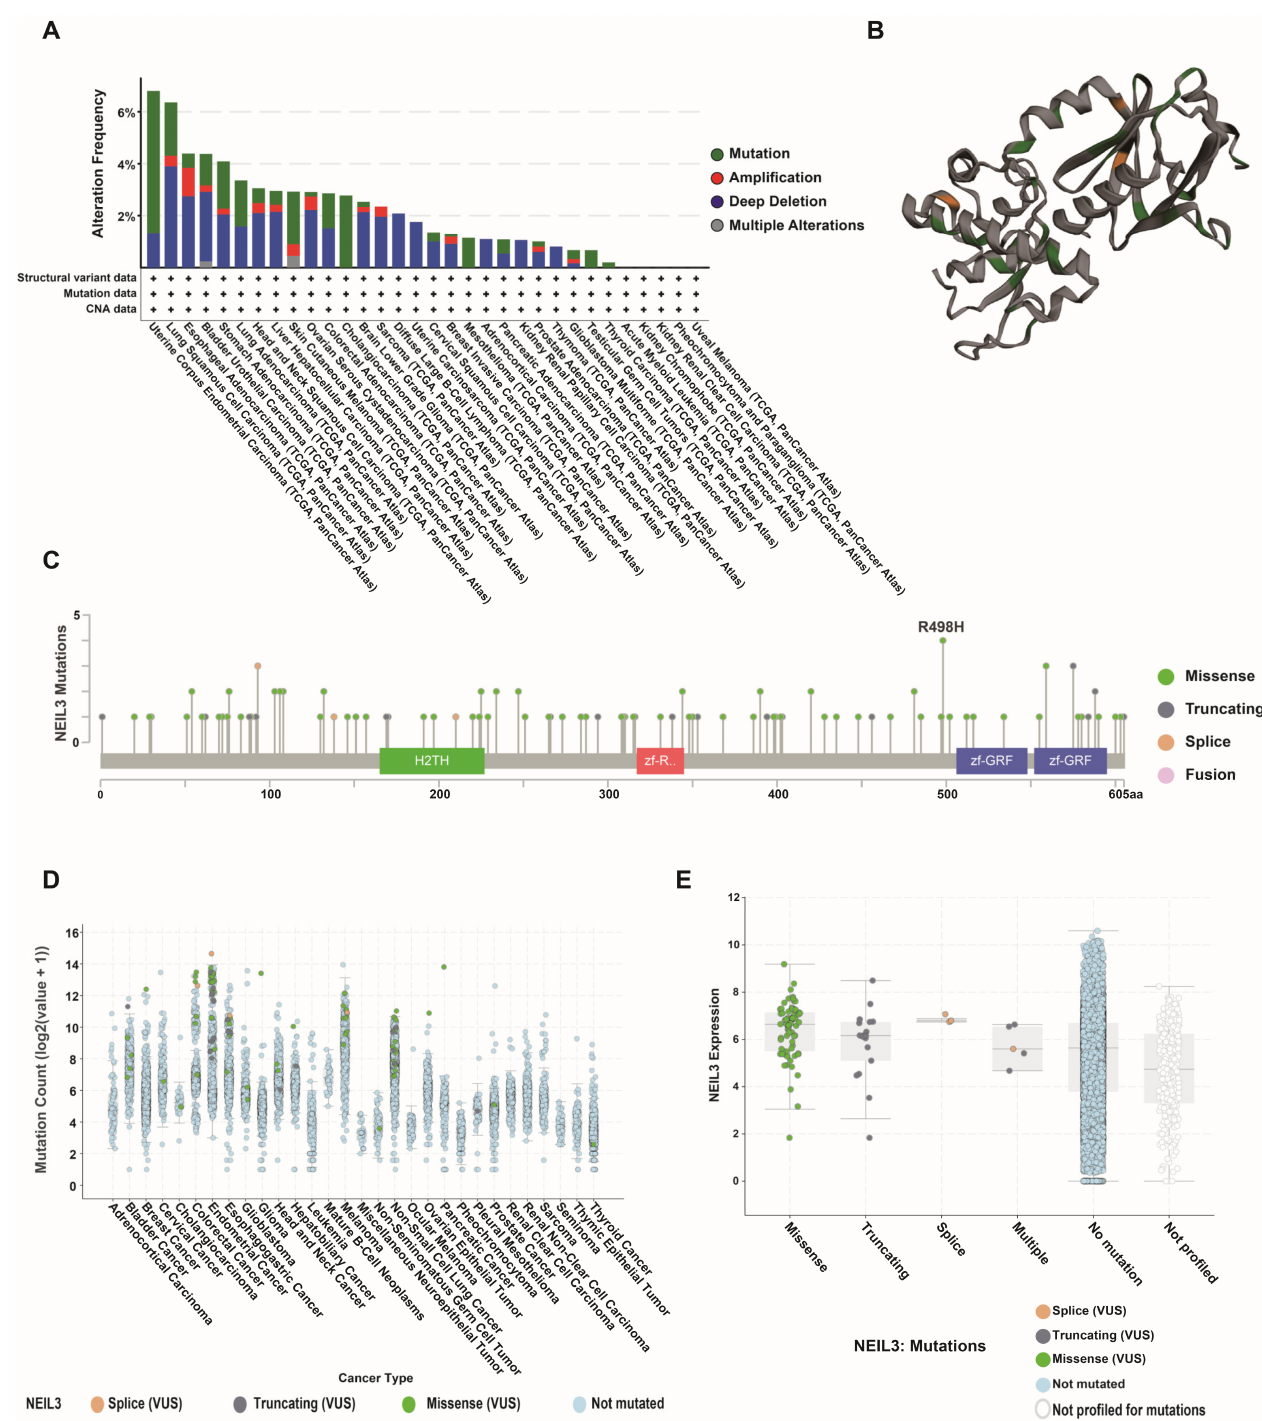
Figure 3. Mutation features of NEIL3 among cancers. ( A ) Alteration frequency of NEIL3 among 33 types of cancers. ( B ) Three-dimensional structure diagram of the NEIL3 protein. The green part represents the missense mutation area, black represents the truncating mutation area, and orange represents the inframe mutation area. ( C ) Mutation diagram of NEIL3. Light green circles repre- sent missense mutations, light orange circles represent splice mutations, and gray circles represent truncating mutations. In the case of different mutation types at a single position, the color of the circle represents the most frequent mutation type. ( D ) Fractional genomic alteration of NEIL3 across 32 cancers. Each dot represents a sample. ( E ) Mutation types of NEIL3 at mRNA expression